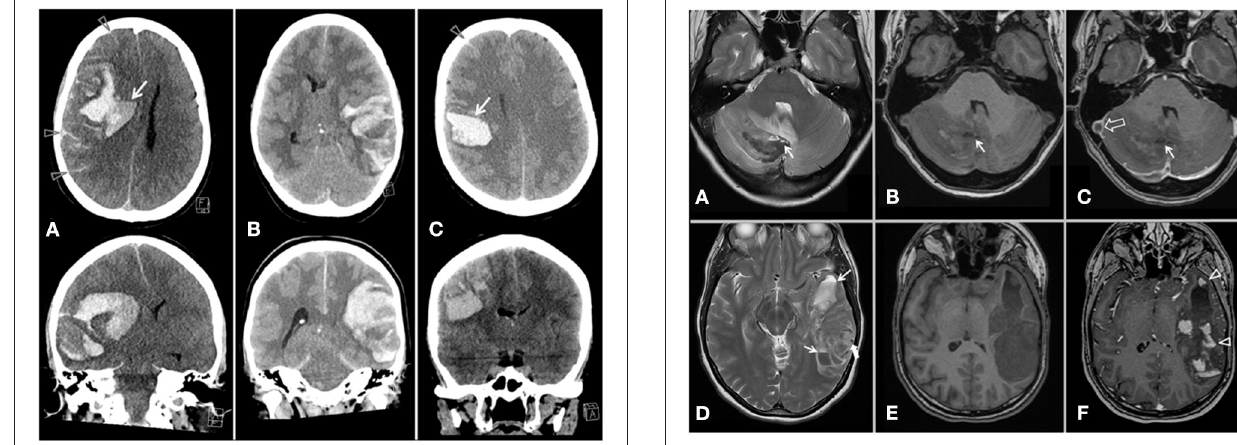
FIGURE 1 | Axial and coronal CT from patient 1 (A) , 2 (B) and 5 (C) . These patients presented with large parenchymal hemorrhages. Note the fluid-fluid levels [arrows, (A,C) ], the subarachnoid hemorrhage [arrowheads, (A,C) ] and the heterogeneous appearance of all hematomas.